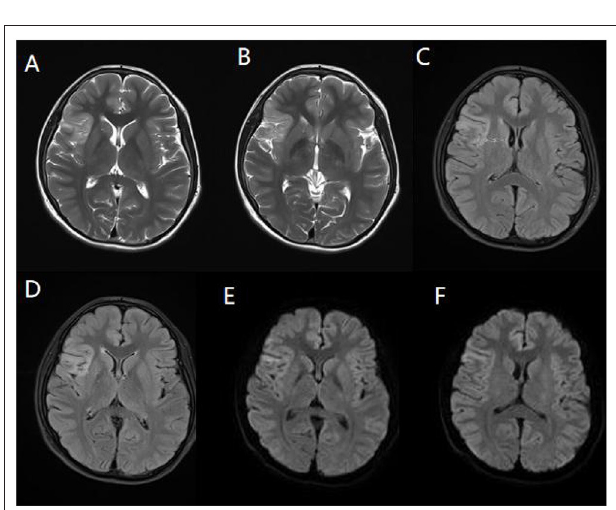
FIGURE 3 | Magnetic resonance imaging (MRI) of a representative pediatric patient admitted for convulsions for 2 weeks and diagnosed with anti-NMDA receptor encephalitis (NMDA receptor antibody in CSF was 1:100). Right temporal and insula lobes and frontal cingulate gyrus showed lamellar abnormal signasl. T2WI showed a high signal (A,B) . FLAIR sequence was dominated by a high signal (C,D) , and DWI showed a high signal (E,F)